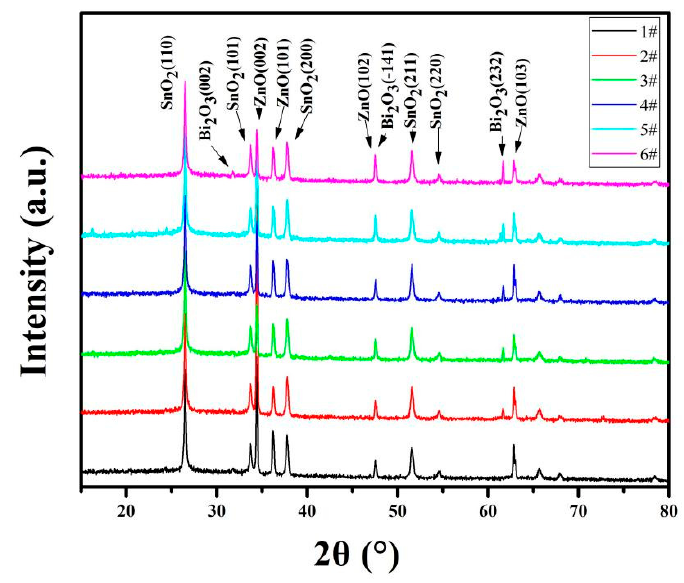
Figure 1. Shows the XRD pattern of ZnO nanoarrays + Bi 2 O 3 . 1. Pure ZnO nanoarrays; 2.